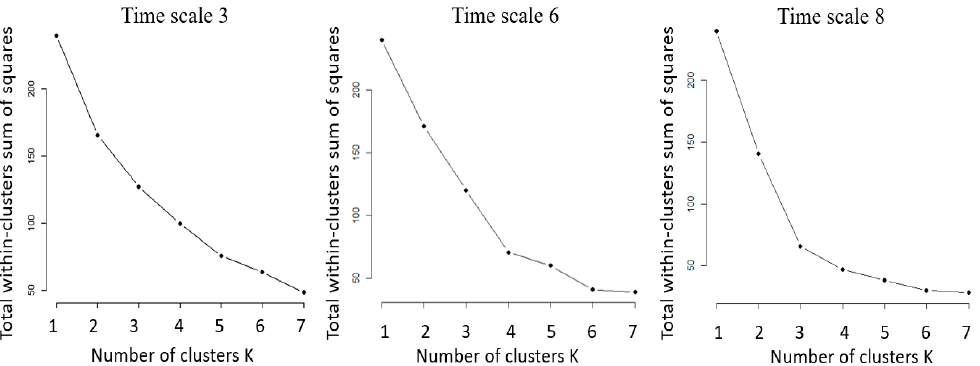
Figure 2. Total within-cluster sums of squares for time scales 3, 6 and 8.